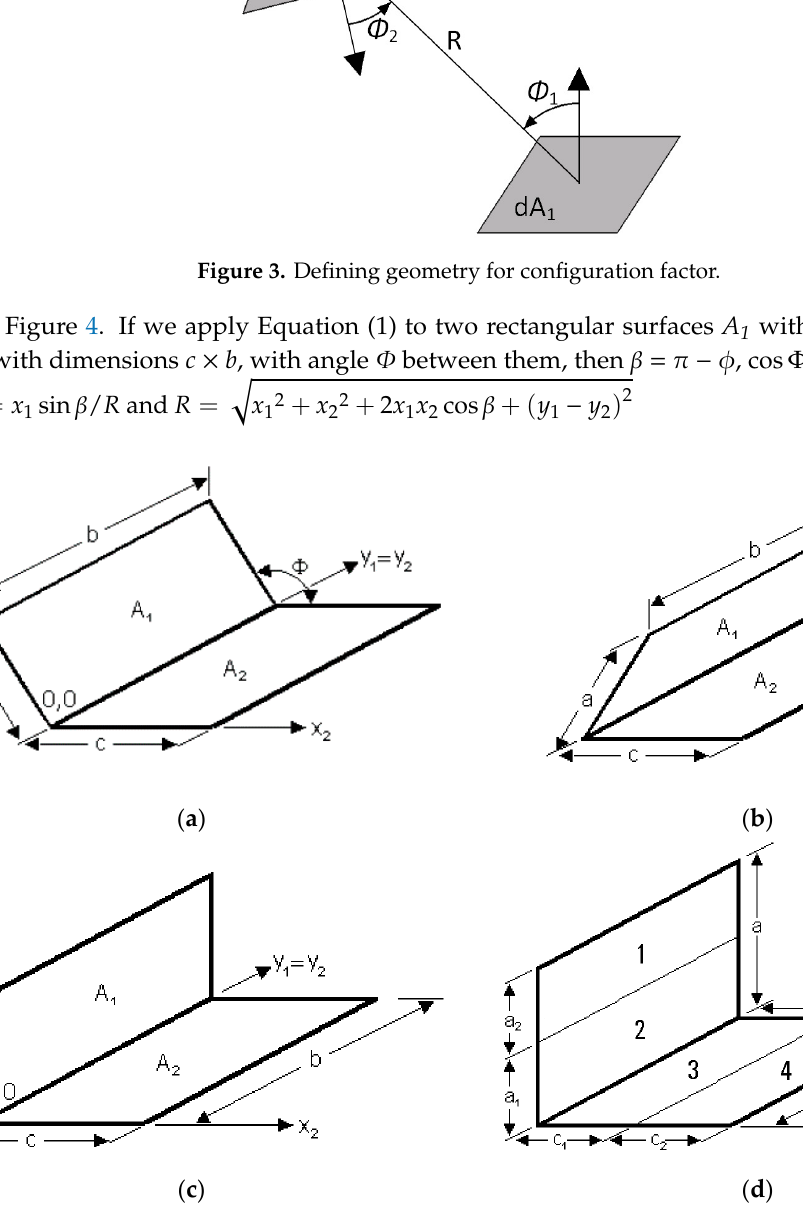
Figure 3. Defining geometry for configuration factor.